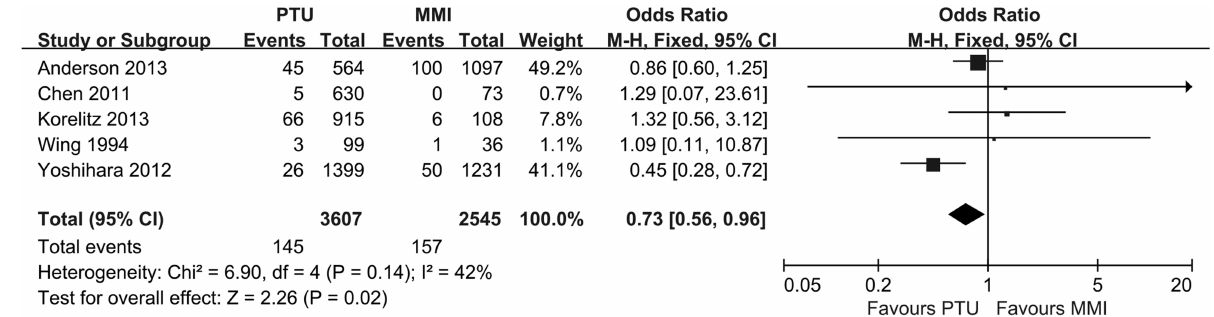
Figure 5 - Forest plot of the odds ratios and 95% confidence intervals of the pooled studies comparing PTU-treated pregnant hyperthyroid women with MMI-treated pregnant hyperthyroid women according to the risk of congenital